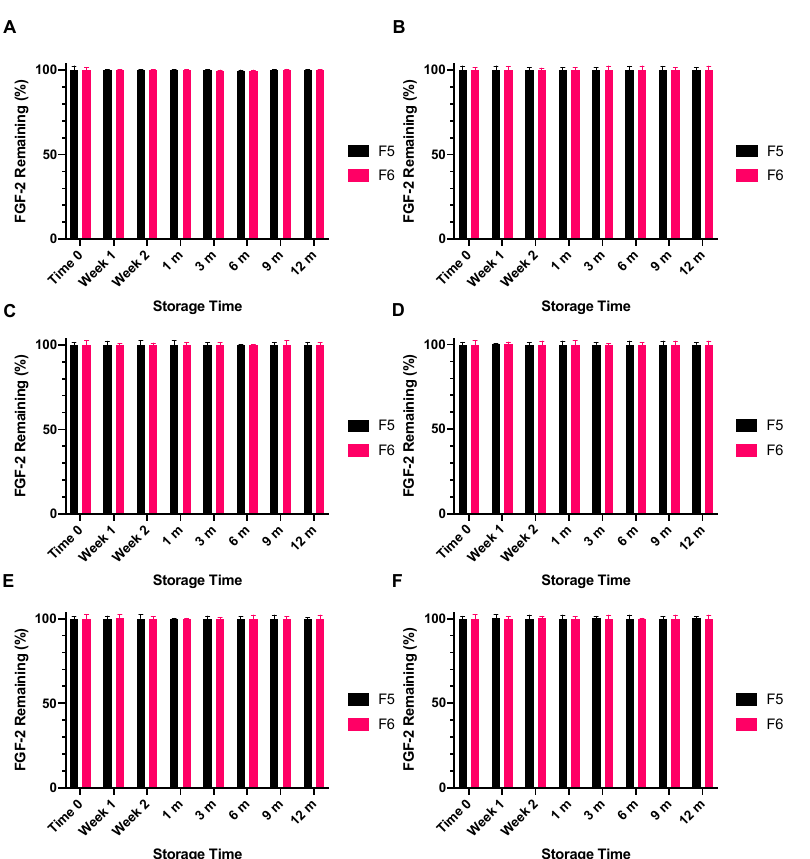
Figure 11. Effect of excipients on the stability of reconstituted FGF-2 aqueous solutions (770 ng/mL) over a 7-day period. FGF-2 in solutions F5 (MC 0.05% w/v and alanine 20 mM) and F6 (MC 0.05% w/v and human serum albumin 1 mg/mL) were lyophilised over 24 h and the dry powders stored at − 4 ◦ C ( A , B ), 4 ◦ C ( C , D ) or 18 ◦ C ( E , F ) for up to 12 months. At the defined storage time points, the FGF-2 powders were reconstituted with water, and the resultant solutions were stored for 7 days at 4 ◦ C ( A , C , E ) or 7 days at 18 ◦ C ( B , D , F ). The FGF-2 content in the stored solutions was determined by ELISA and expressed as a percentage of the baseline FGF-2 content determined in the FGF-2 solutions prior to lyophilisation (mean ± SD, n = 3).